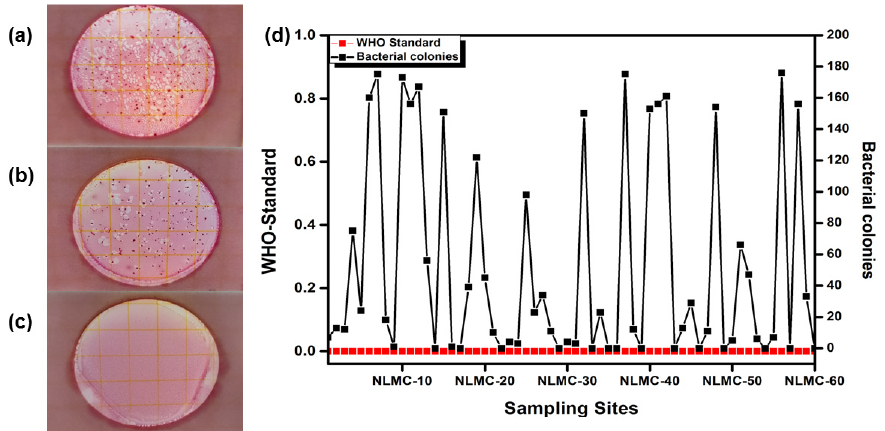
( c ) bacterial-free sample and ( d ) WHO standards for bacterial contamination and the number of colonies obtained at different sites of DNLM in the current experiments.